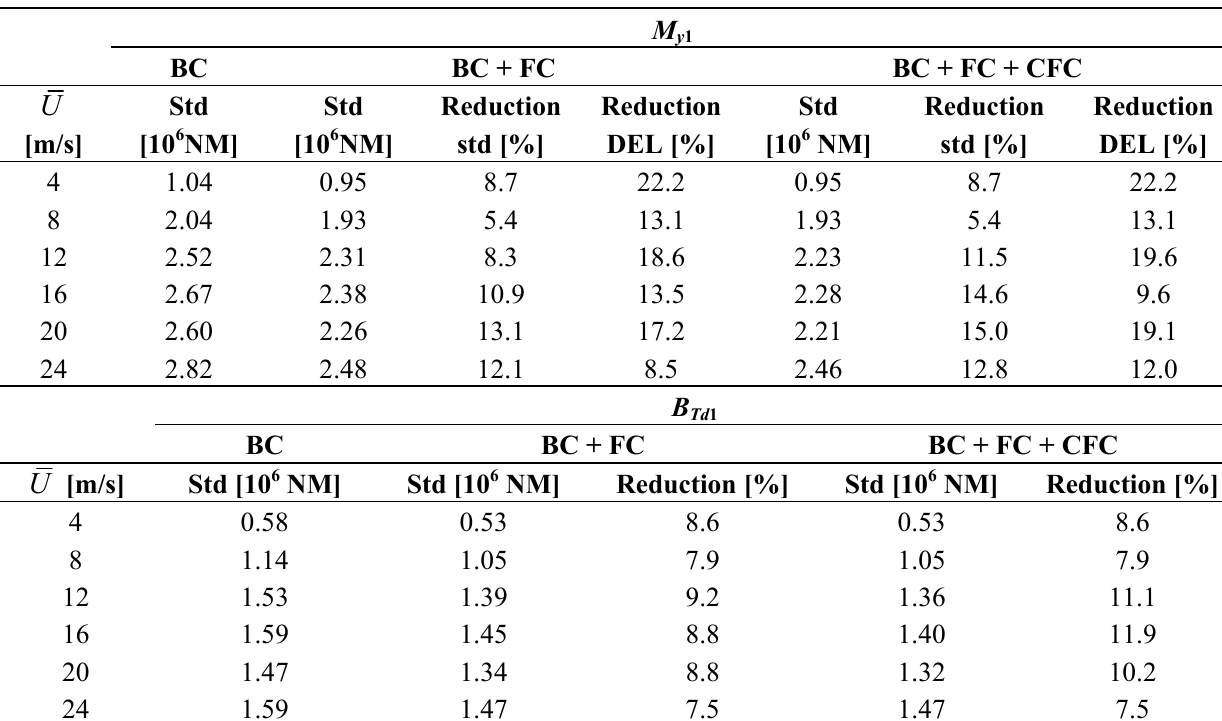
and B for ETM y 1 Td 1